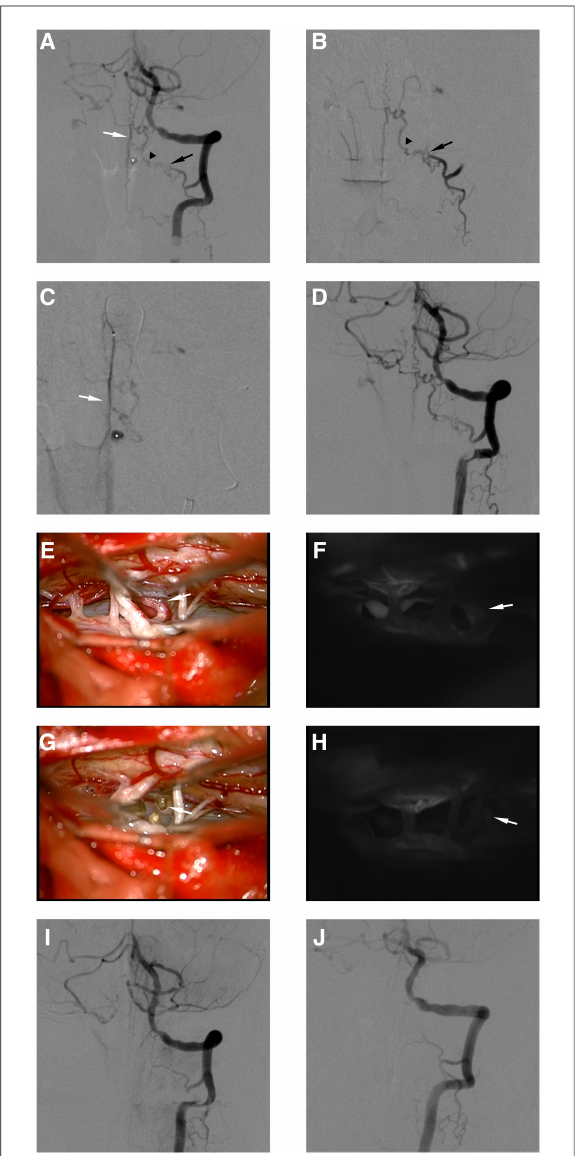
TABLE 3 Treatment and outcome according to spinal arterial feeders.